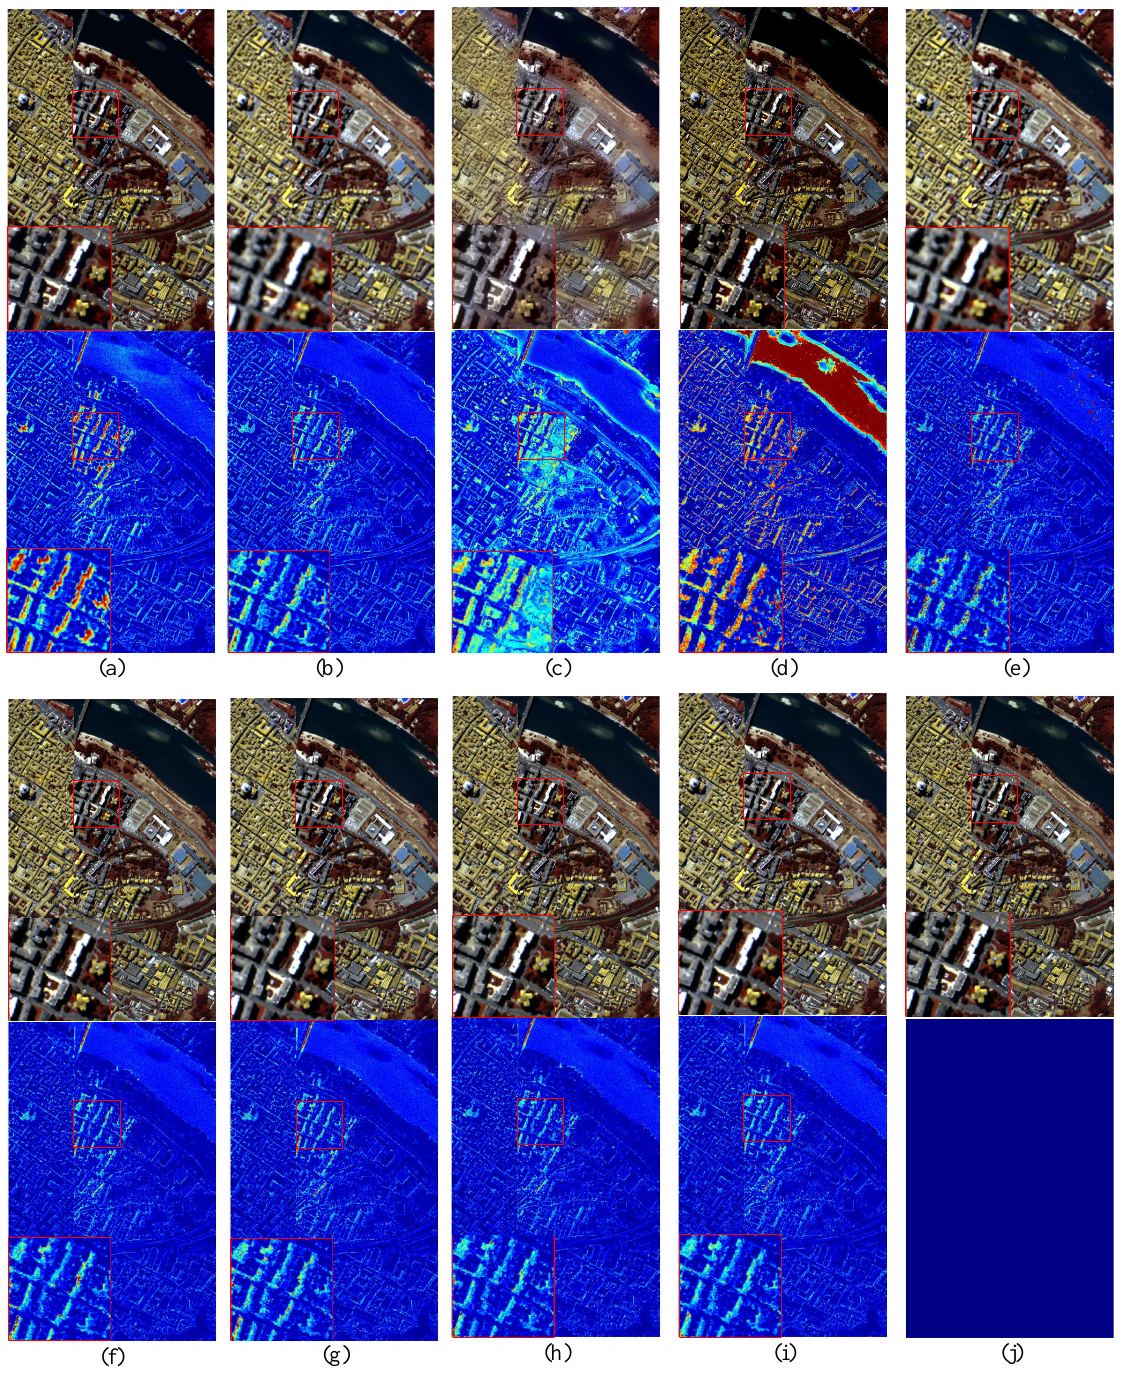
Figure 8. The visual results of different methods on the Pavia Center dataset. ( a ) CNMF; ( b ) Bayesian naive; ( c ) GFPCA; ( d ) PanNet; ( e ) DDLPS; ( f ) Original RCAM; ( g ) Original MSRNet; ( h ) S 1 (RCAM) in the SSML framework; ( i ) S 2 (MSRNet) in the SSML framework; ( j ) Ground truth. Note that the false color image is selected for clear visualization (red: 70, green: 53, and blue: 19). The even rows show the difference maps of the corresponding